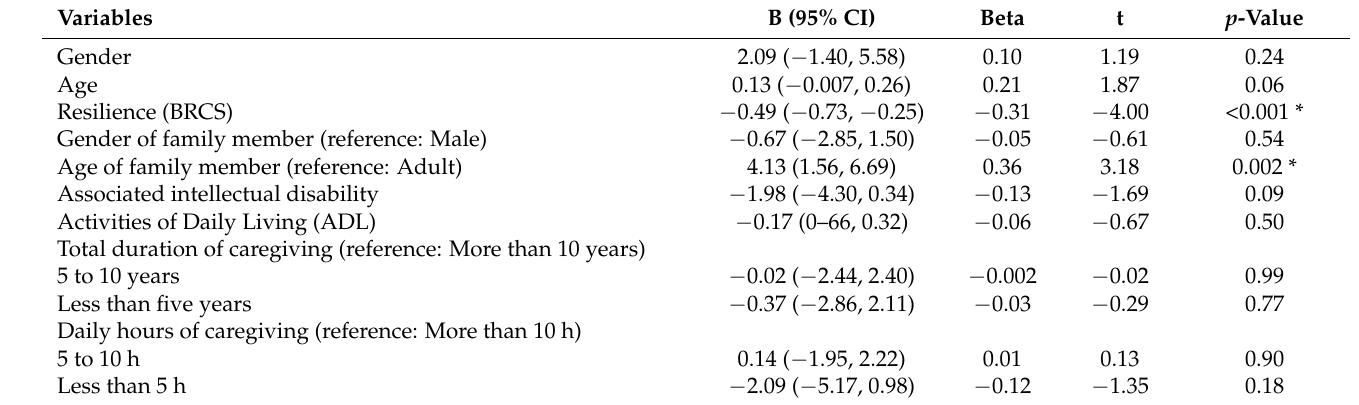
Table 3. Multivariate linear regression evaluating predictors of individual distress (GHQ-12) in the group of autistic